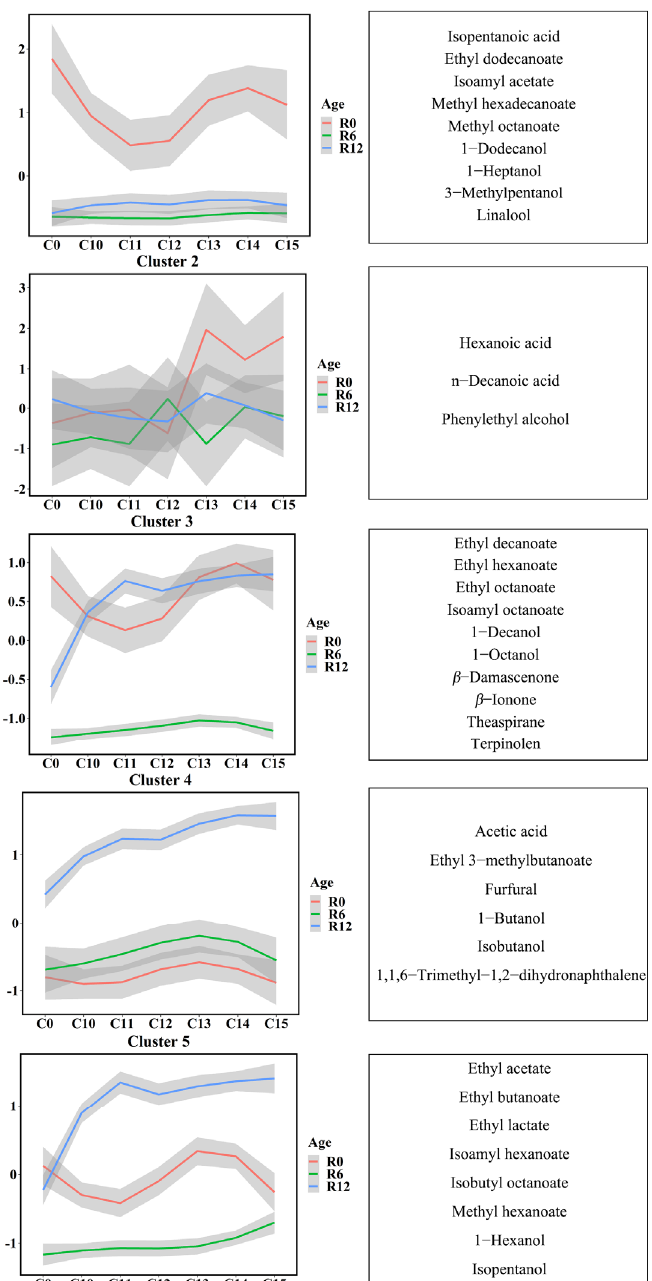
Figure 2. K -means clustering analysis based on the normalized concentrations (left) and the corresponding aroma compounds in each cluster (right) in Riesling wines. “R0” represents before bottling, and “R6” and “R12” individually represent bottle storage for 6 months and 12 months; “T0” represents the control without any cold treatment, and “T10 to T15” individually represent cold treatment for 10 to 15 days. The vertical coordinate was the best value for each center point of the cluster calculated by the k -means